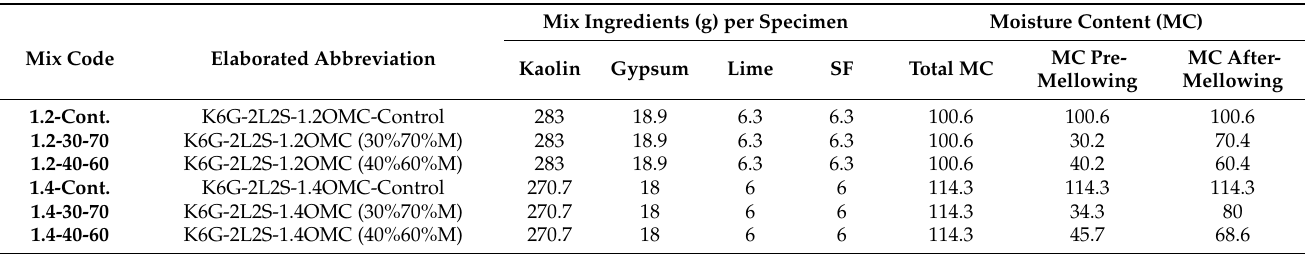
Table 3. Mix compositions of the various sulphate induced kaolinite clay mixes at varying OMC (1.2 and 1.4), stabilised with a blended binder of 2 wt.%lime-2